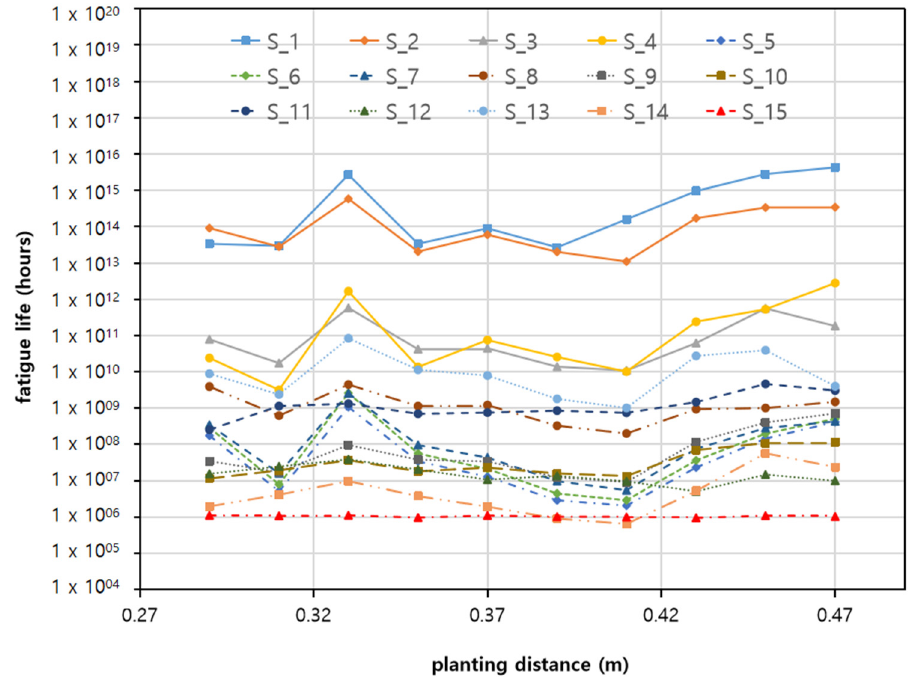
Figure 15. The average fatigue life of the transplanting device according to the planting distance.